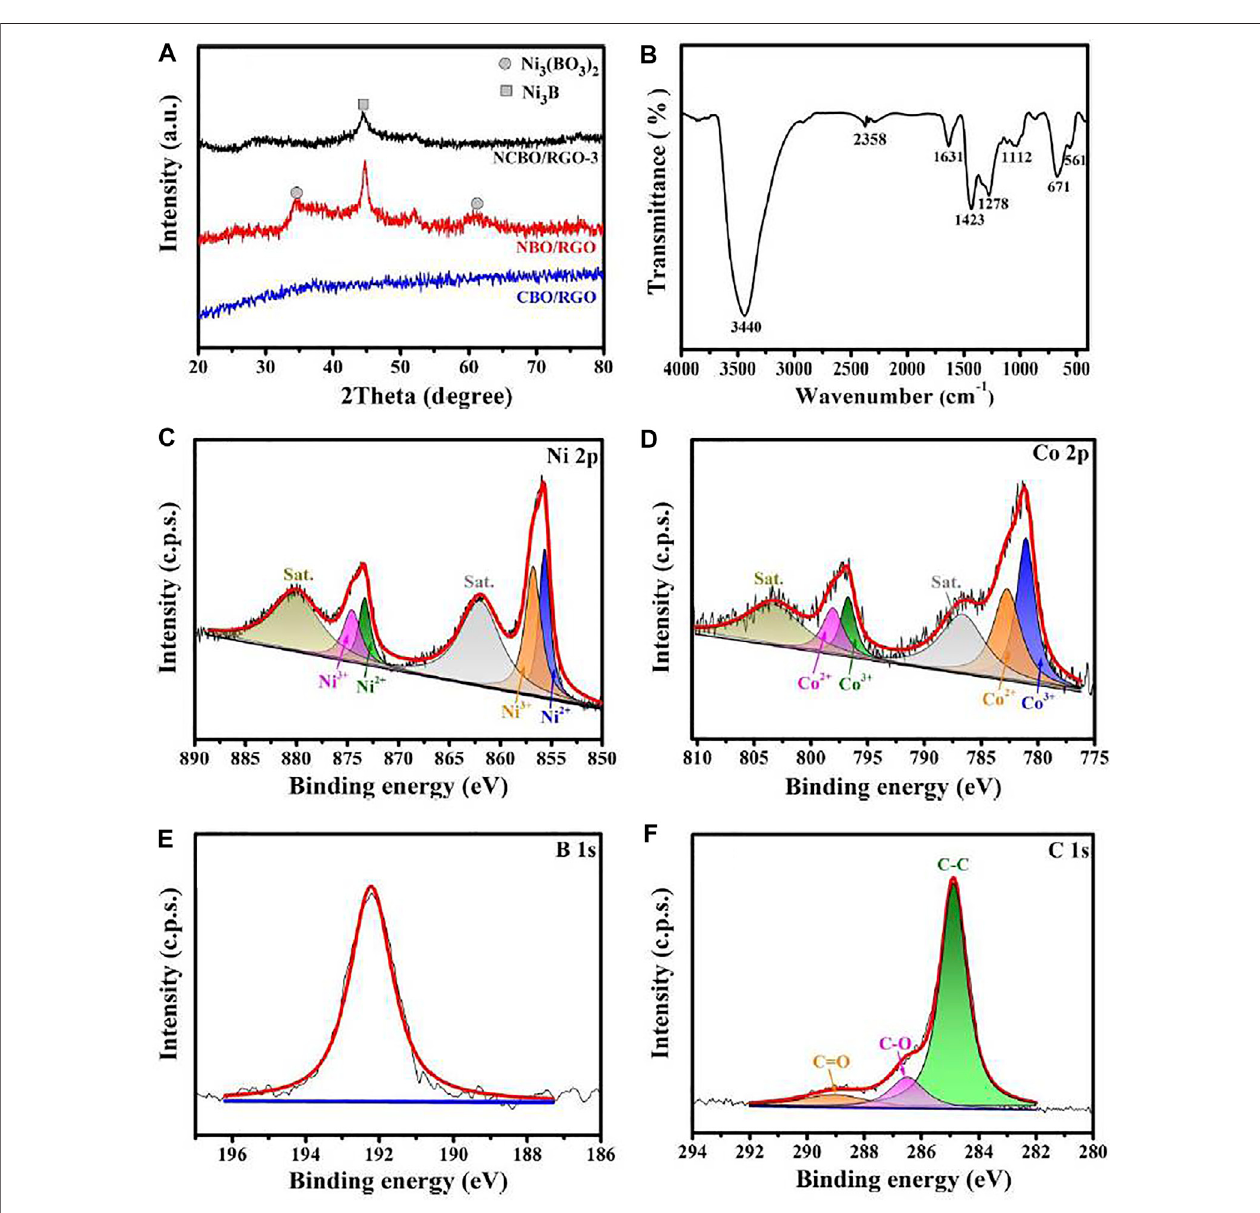
FIGURE4|(A) XRDpatternsofthethreeTMBO/RGOsamples; (B) FT-IRspectrumofNCBO/RGO-3;High-resolutionXPSspectraof (C) Ni2p, (D) Co2p, (E) O1s and (F) C 1s for